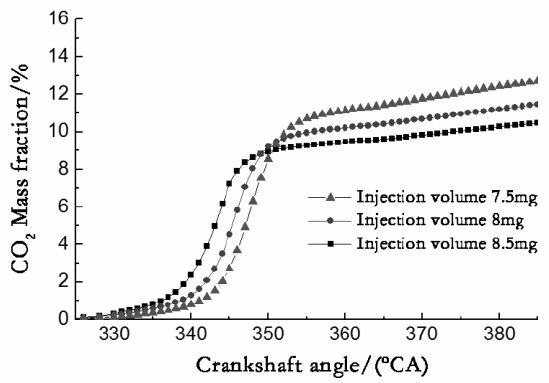
Figure 26. CO 2 curves corresponding to different fuel injection volumes.